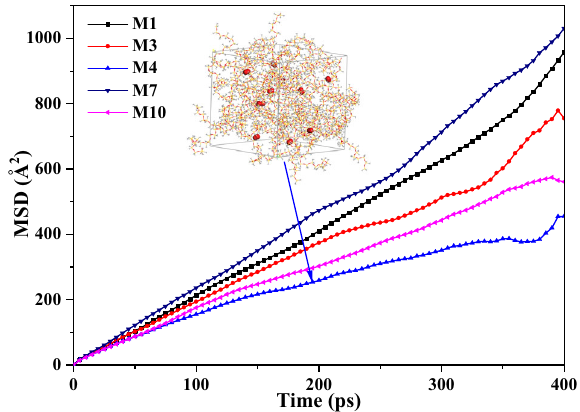
Fig. 13 Diffusion coef fi cients of O 2 molecules in the unaged and aged PDMS models at 298 K. The error bars stand for the standard deviations from fi ve independent sample.